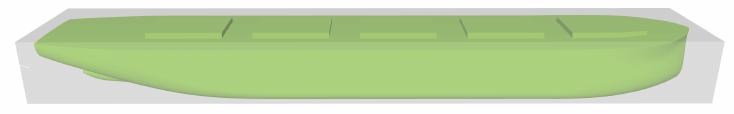
Figure 2. Three-dimensional rectangular bounding box of ship hull.